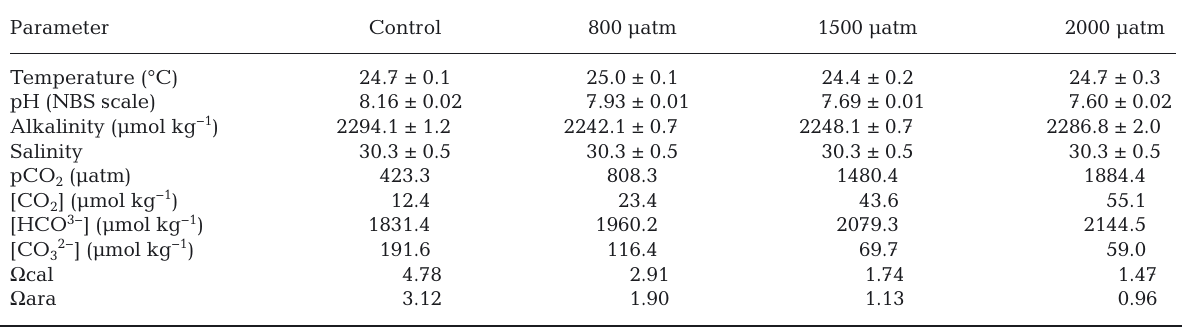
Table 1. Mean ± SD of water chemistry measurements and calcite and aragonite saturation state ( Ω ) of seawater in control and high-pCO 2 groups. n = 3 for all treatments. Parameters such as pCO 2 , concentration of CO 2 , bicarbonate ions and carbonate ions and Ω were calculated by the CO2SYS